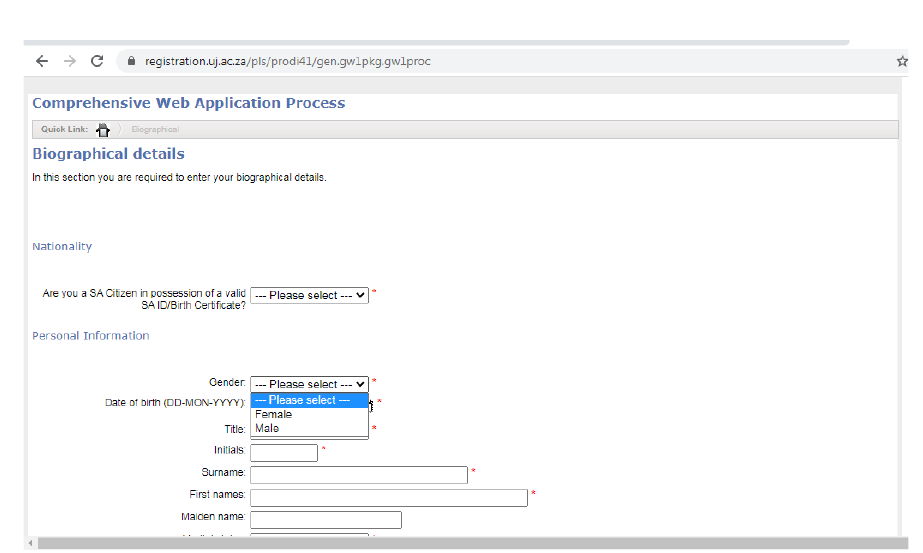
Figure 3 : University of Johannesburg online application form (UJ, 2021)